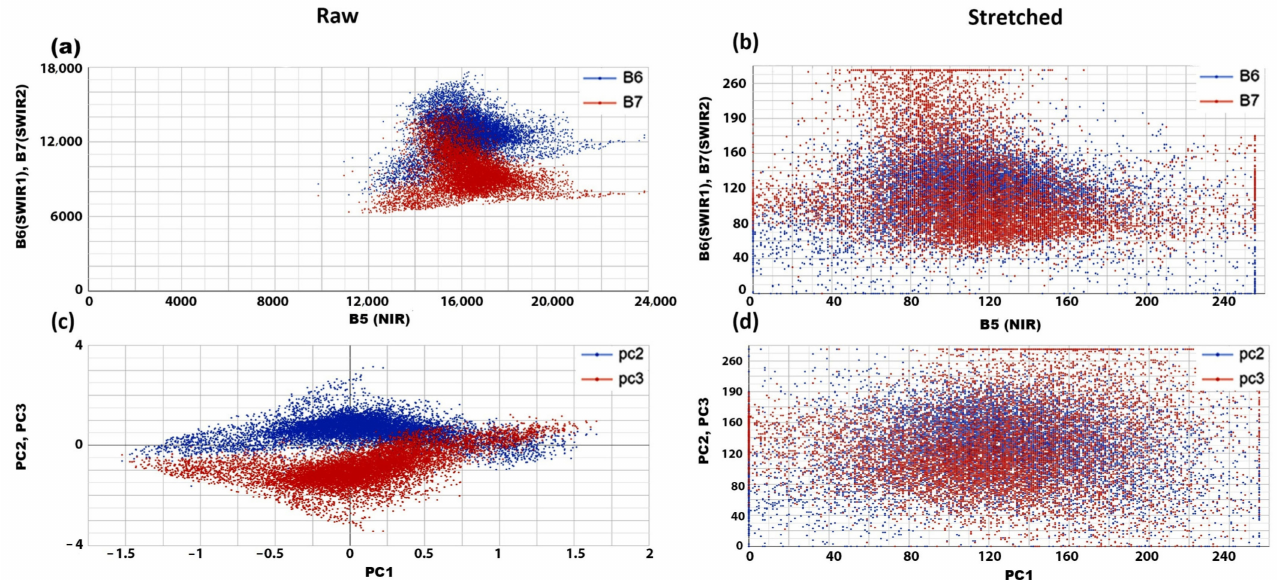
Figure 4. ( a ) Scatter plots showing the effects of the principal component analysis (PCA) and decorrelation stretching of Landsat-8 OLI bands pixel data (raw Landsat-8 B5 (NIR) vs. B6—SWIR1 (blue), and B7—SWIR2 (red)); ( b ) scatter plots of B5 (NIR) vs. B6—SWIR1 (blue), and B7—SWIR2 (red) after the application of decorrelation stretching on raw Landsat-8 data; ( c ) scatter plots of PC1 vs. PC2 (blue) and PC3 (red) after the application of PCA on the raw Landsat-8 datasets; and ( d ) Scatter plots of PC1 vs. PC2 (blue) and PC3 (red) after the application of PCA on the stretched Landsat-8 datasets.